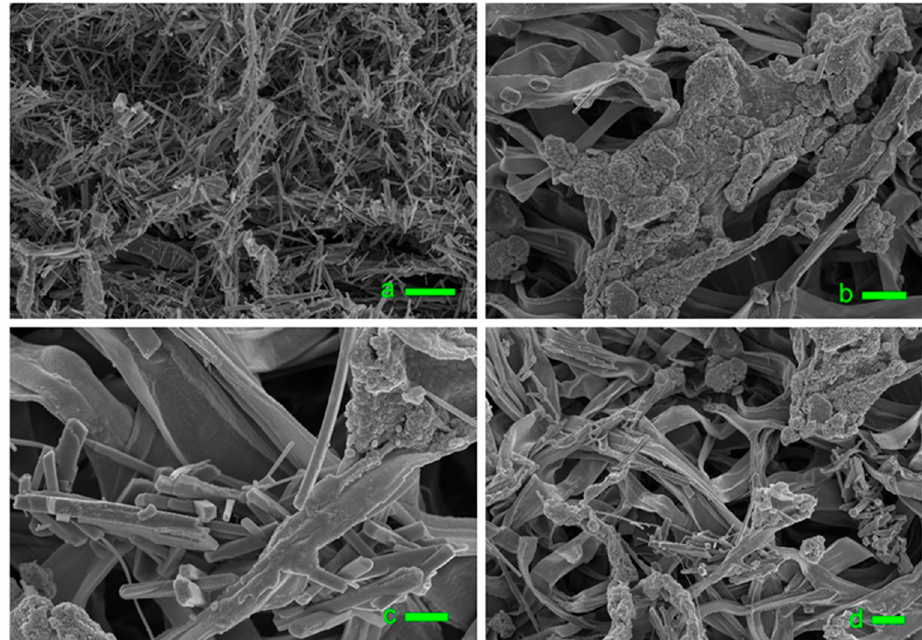
Figure 3. Cord-forming mycelial network at compost-soil touching layer during the pilot glasshouse experiment of Agaricus subrufescens under SEM. Photos taken from soil, compost, and A. subrufescens group (SCA) on day 55; ( a ) crystalline mycelium; ( b ) soil particles; ( c , d ) hyphae-soil connection; Scare bar: a 10 µ m; ( b , d ) 5 µ